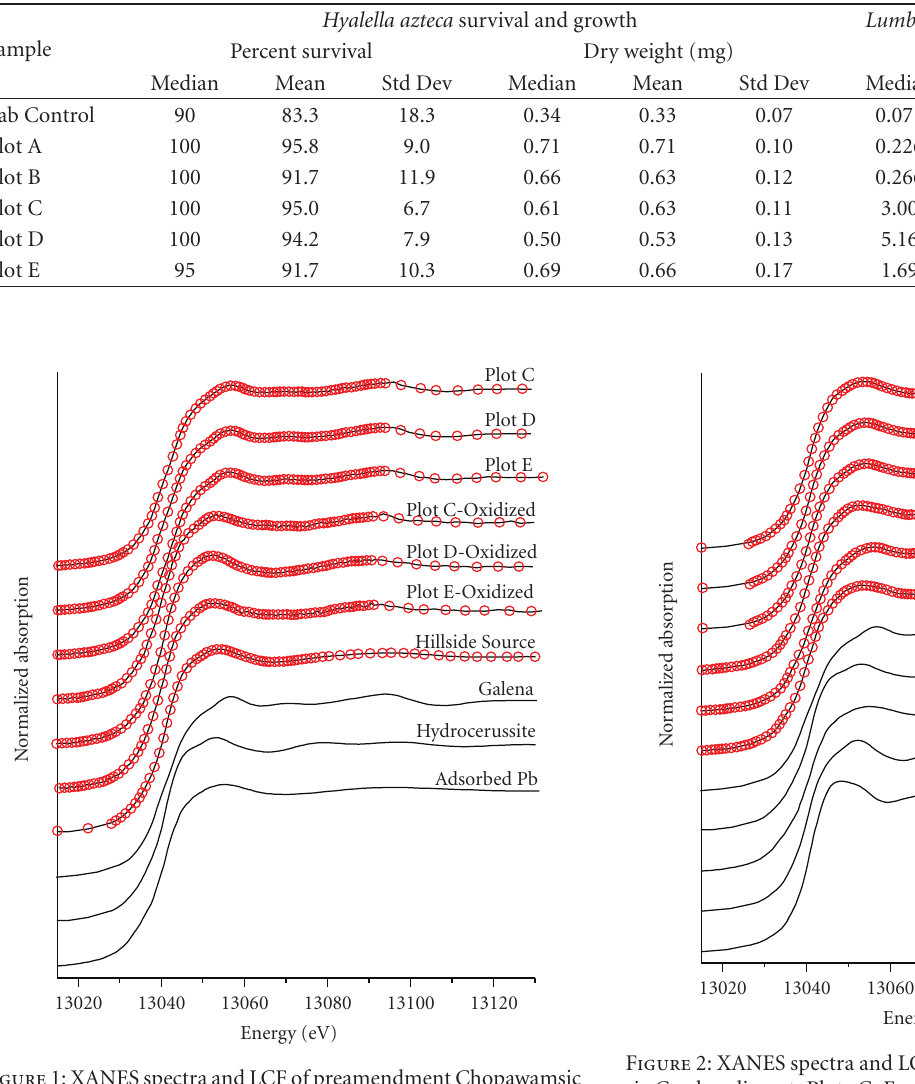
Figure 1: XANES spectra and LCF of preamendment Chopawamsic Creek sediment and the firing range source soil (Hillside Source).